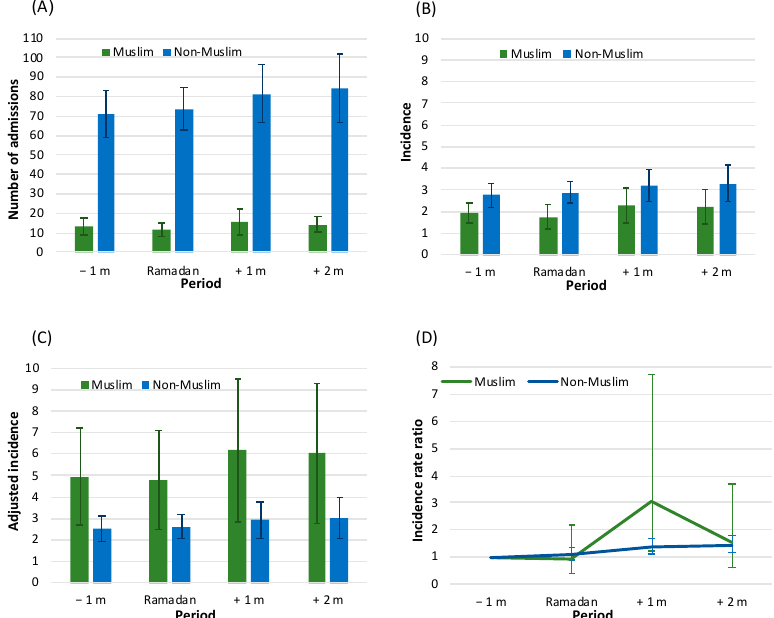
Figure 1. Incidence data of acute myocardial infarction (AMI) by study time period among Muslims and non-Muslims: ( A ) number of admissions, ( B ) unadjusted incidence (/1000), ( C ) adjusted incidence (/1000), and ( D ) incidence rate ratio. Number of admissions and incidence rates (/1000) (panels A – C ) are presented as annual average and standard deviation (SD); (Panel C )—direct age and sex adjustment, standard population—the Israeli population in the year 2017; (Panel D )—incidence rate ratio (IRR) and 95% confidence interval (CI) from generalized linear models (GLM), scaling by the population size in each study year. Legend: − 1 m—month prior to Ramadan, Ramadan—month of Ramadan, +1 m—one-month post-Ramadan, +2 m—two-months